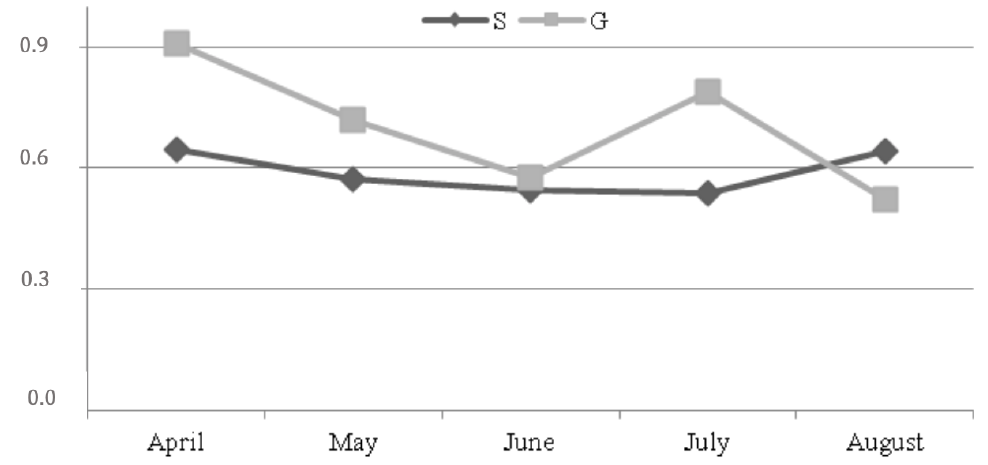
Figure 2. SCD expression (AU: Arbitrary unity) along the trial (*SEM = 0.362). * standard error of mean.